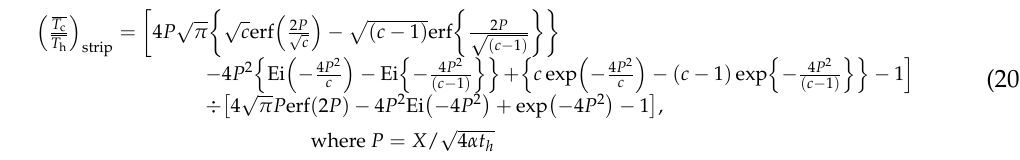
Figure 6 by comparison with point, line and plane heat source geometries. When P takes a small value, it means a narrower strip, and the gradient of the decreasing ratio is similar to the gradient of the line source t − 2/2 . When P takes a larger value, it means a wider strip, and the gradient is similar to